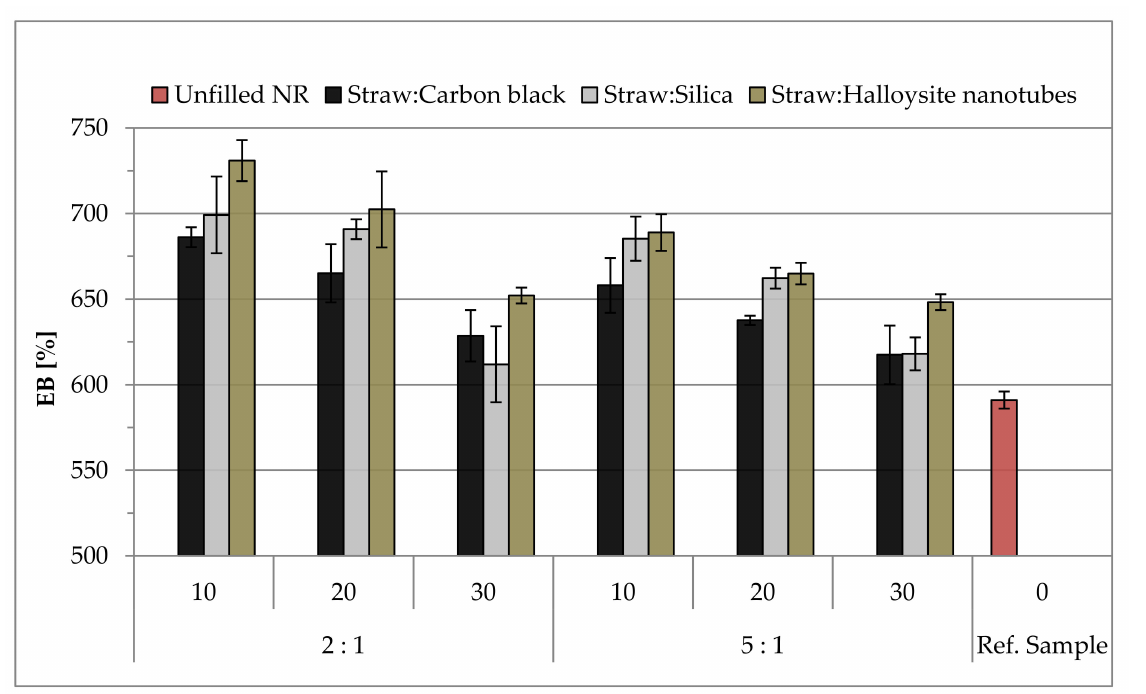
Figure 15. The elongation at break (Eb) parameters of natural rubber